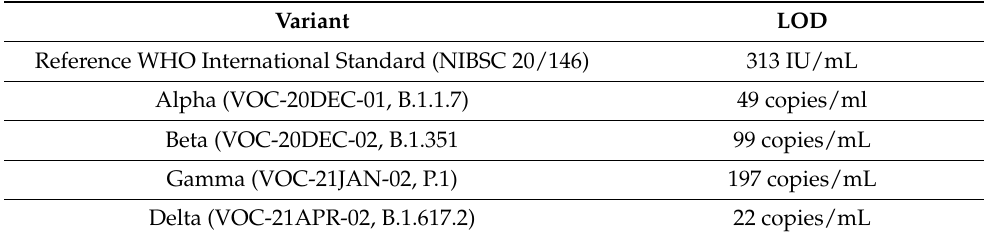
Table 2. Analytical sensitivity (limits of detection—LOD).